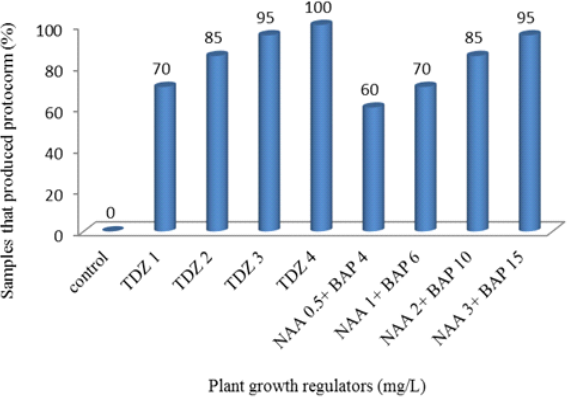
Fig. 1. The effect of growth regulators on the percentage of leaf samples that produced protocorms